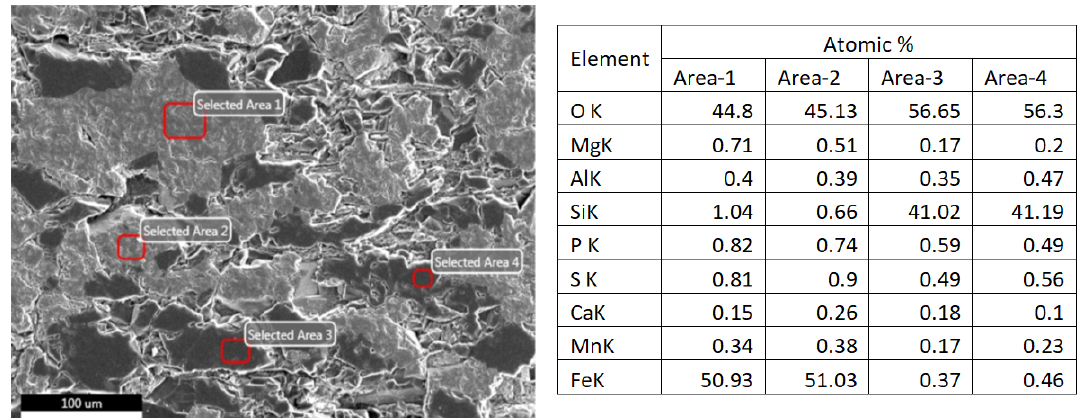
Figure 6. EPMA analysis of the BHQ sample of study area.